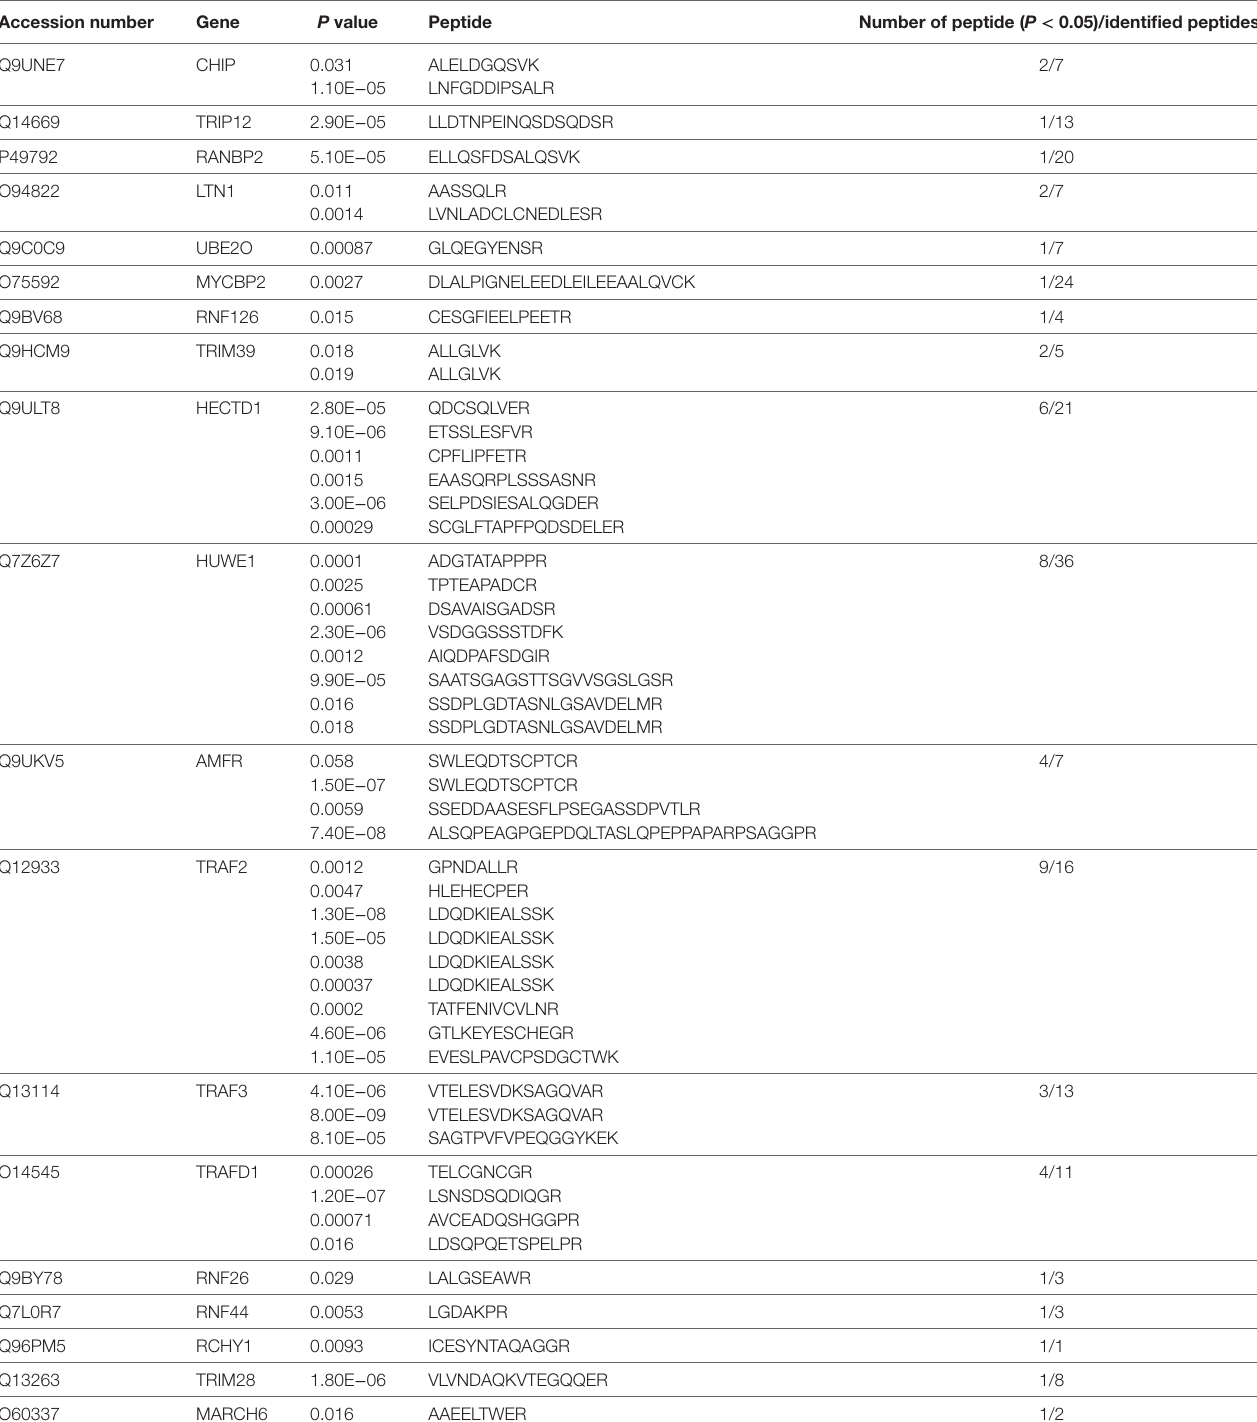
TaBle 1 | The E3 ligases interact with LMP1-identified by